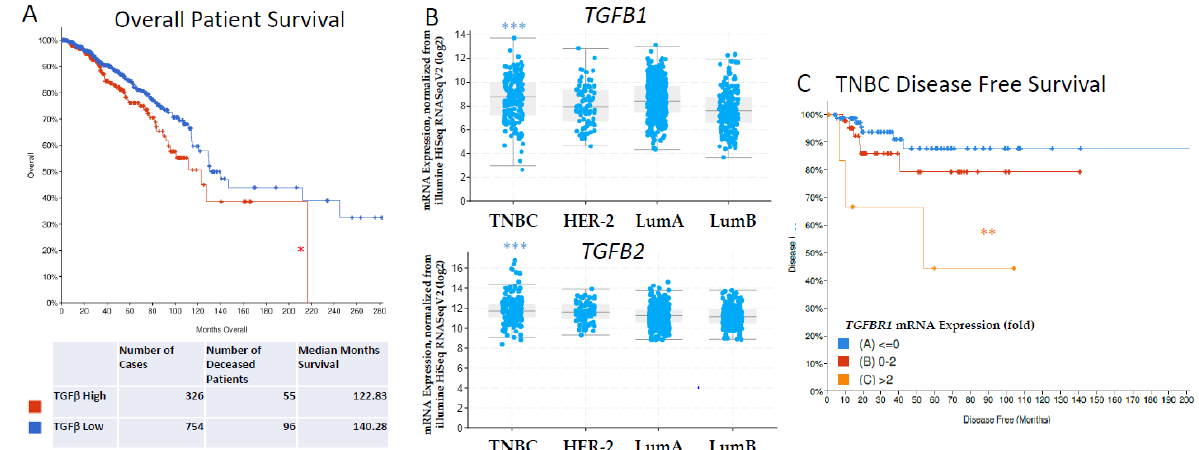
Figure 2. Database Analysis of TGF- β Gene Expression and Survival in Breast Cancer Patients. ( A ) Kaplan–Meier curves for overall survival of the patients with high expression of TGF- β signaling in cancer samples (red curve) in comparison with patients with unaltered expression (TGF- β low, blue curve). n = 1082, * p = 0.0303, log-rank test. ( B ) Patient breast cancer samples ( n = 1082) were stratified based on TNBC, HER-2 +, Luminal A and Luminal B subtypes and TGF-B1 (*** p = 5.42 × 10 − 12 ) and TGF-B2 (*** p = 4.19 × 10 − 10 ) gene expression was assessed. ( C ) Invasive breast cancer samples which were of the TNBC subtype ( n = 137) were then stratified and separated into categories based on TGF-BR1 mRNA expression (log RNA Seq V2 RSEM) to generate a Kaplan–Meier curves for disease-free survival ** p = 8.710 × 10 − 3 .